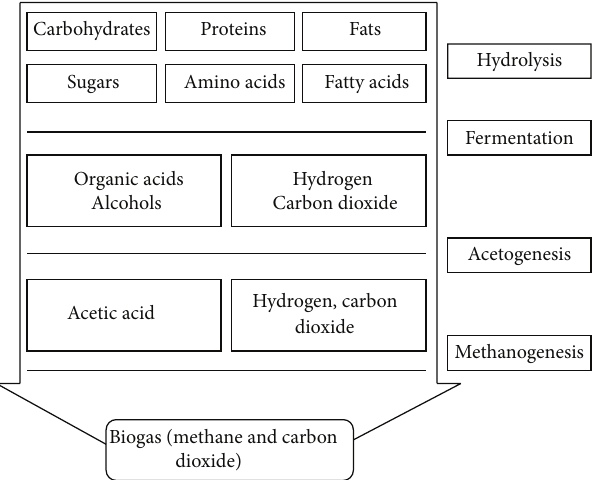
Figure 2: Schematic diagram showing the sequential steps of biogas